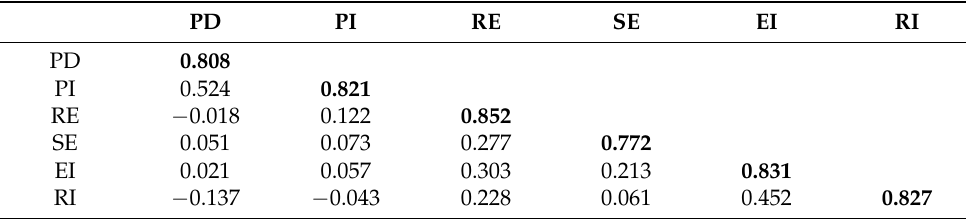
Table 4. Discriminant validity (Fornell–Lacker